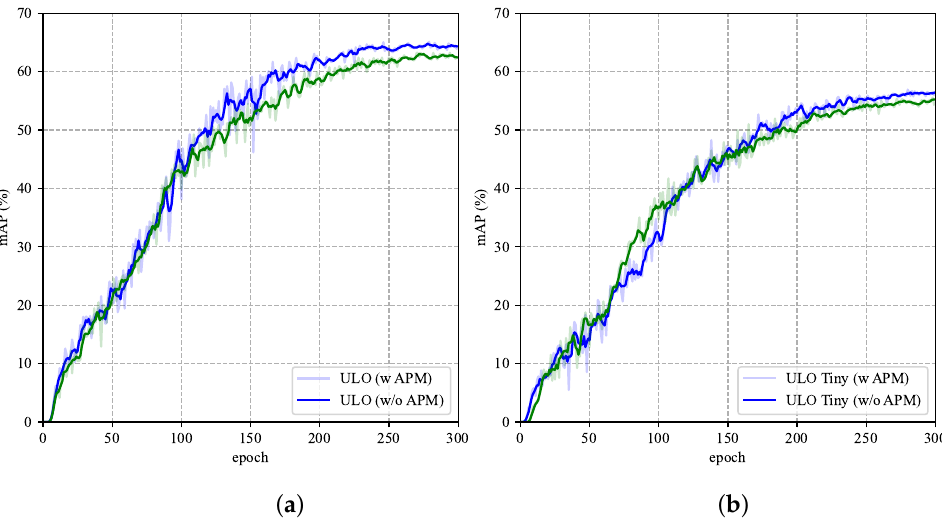
Figure 8. The mean average precision values tested on the validation set during training. The models with APM have a more significant performance improvement in the middle and final stages of training than those without. ( a ) ULO. ( b ) ULO